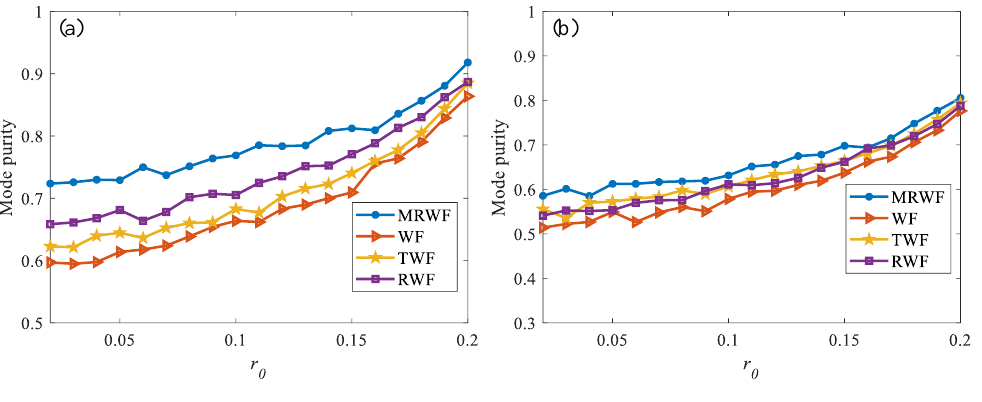
Figure 9. Comparison of model purity after recovery by different algorithms: ( a ) turbulence effects; ( b ) turbulence and pointing error effects.